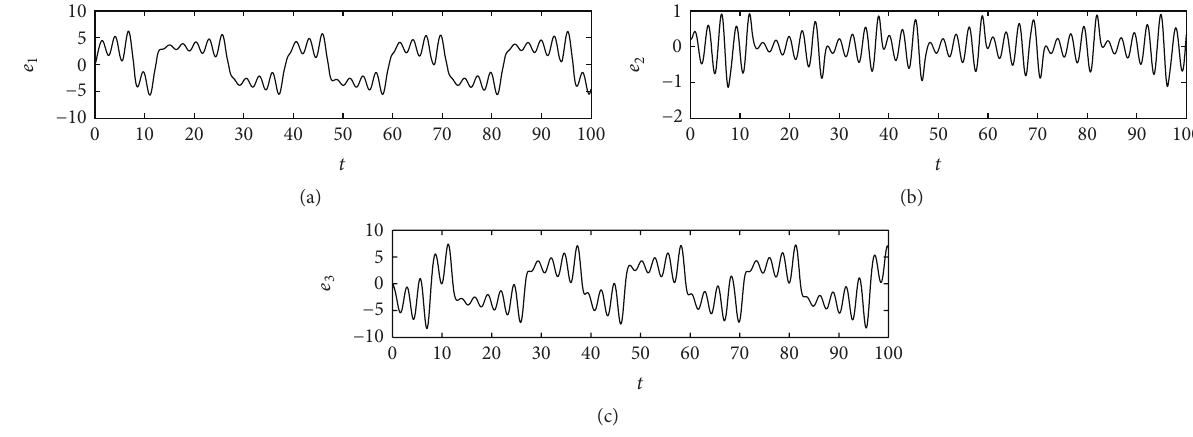
Figure 5: Time evolution of CNN